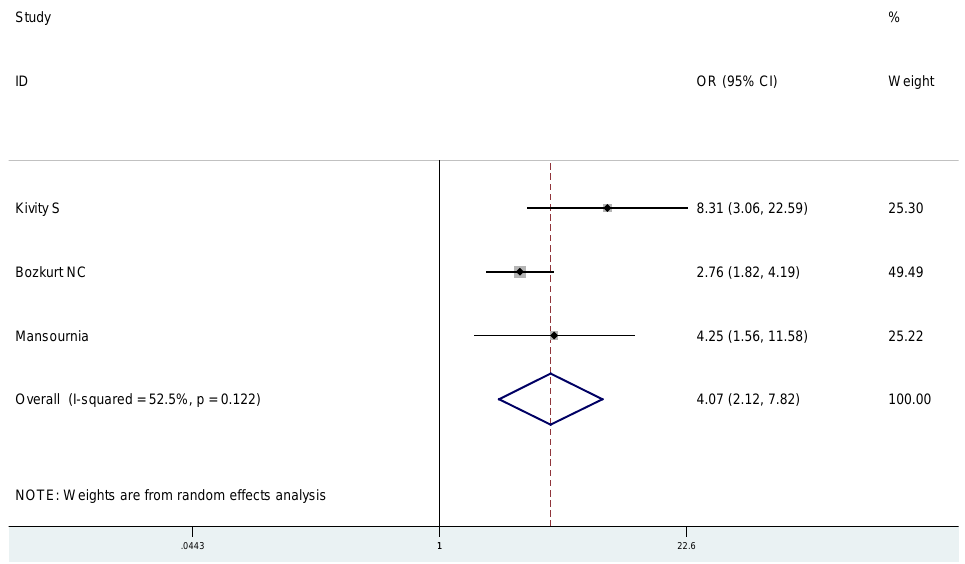
Figure 7. Meta-analysis of studies (chronologically ordered) reporting dichotomous data of 25(OH)D levels in Hashimoto thyroiditis vs. controls and estimated ORs with 95% confidence